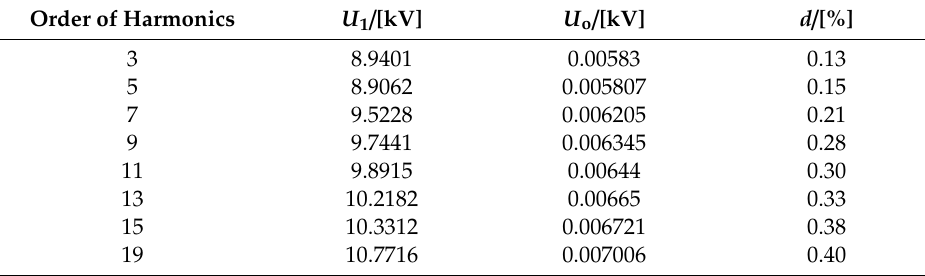
Figure 14. ( a ) Short circuit waveform of ECVT and ( b ) Reclosing waveform of ECVT. Table 3. Relationship between harmonic and voltage error.